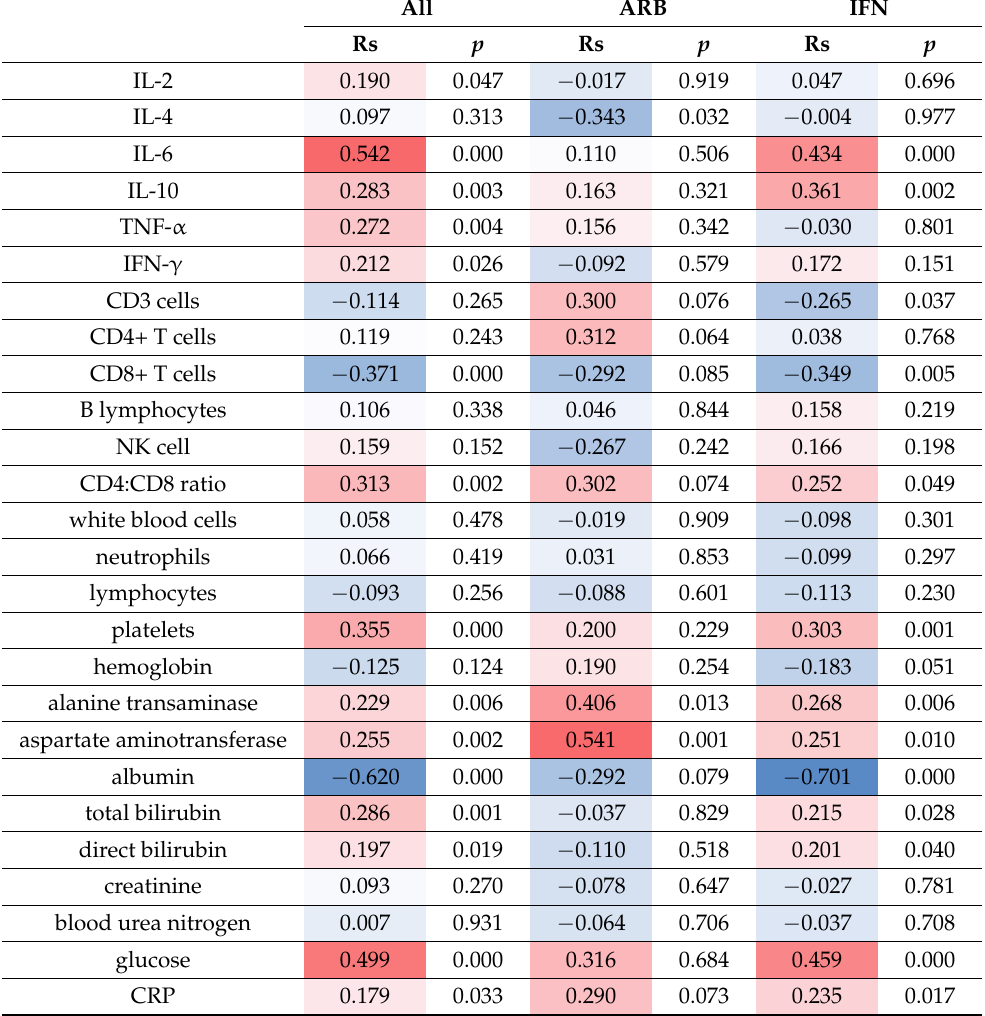
Table showing Spearman correlation coefficients (Rs) and p values between CT score and various blood-based markers in the entire cohort (All) or in the ARB or IFN treatment groups, separately. Color scale indicates the correlation coefficient value and corresponds to the heat map in Figure